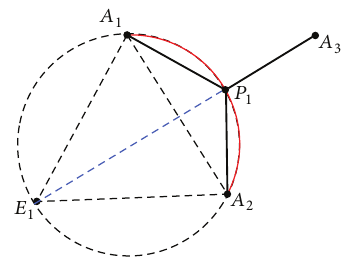
Figure 5: Picture for 3 points using Rule